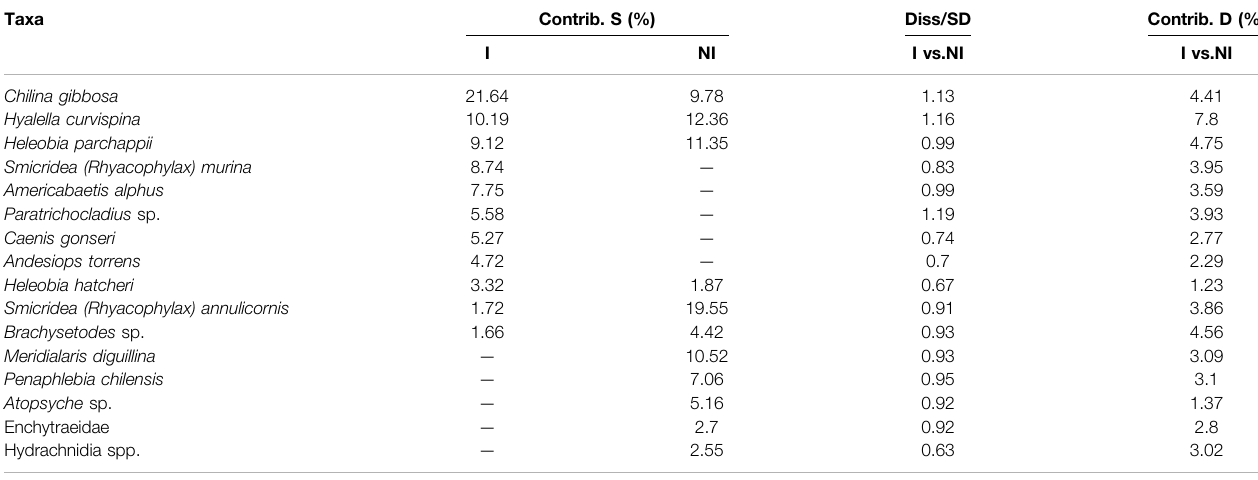
TABLE 4 | Summary of Similarity Percentage analysis (SIMPER) of macroinvertebrate, showing the organisms which most contributed to the observed differences among groups (I, invaded and NI, not invaded sites). Contrib.S, contribution to the intragroup simillarity; Diss, mean disimillarity and their SD, standard deviation; Contrib.D, contribution to the intergroup disimillarity.